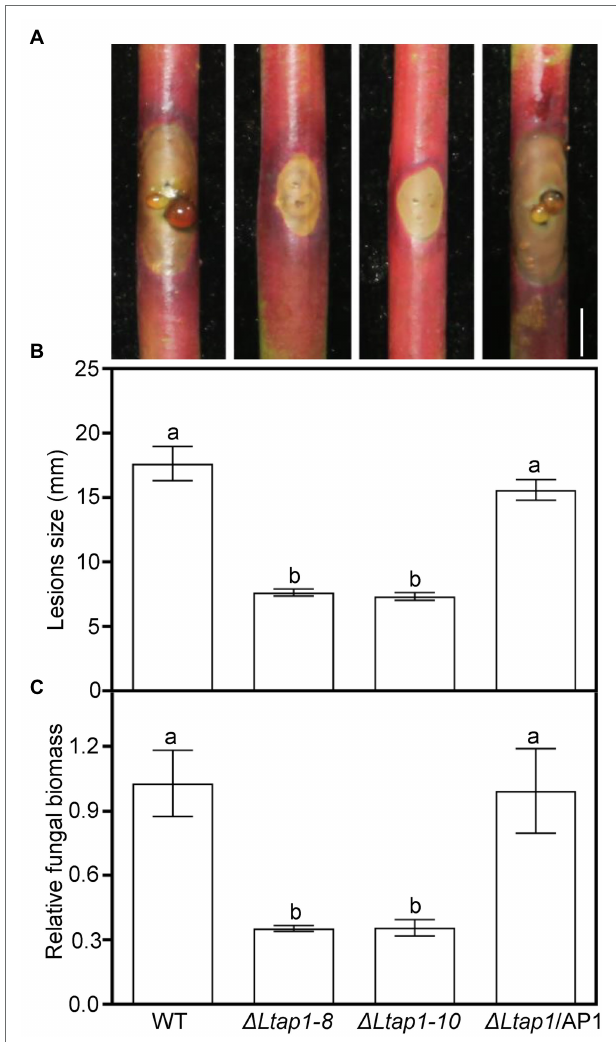
FIGURE 5 | Virulence test of the LtAP1 mutants into peach shoots. (A) Peach gummosis progression in the detached shoots inoculated with different genotypes of L. theobromae (WT, two deletion mutants, and the complementary strain Δ Ltap1 /AP1) at 5 dpi. Bar represents 5 mm. (B) Quantification of lesion size on inoculated peach shoots. (C) Quantitative real-time PCR (qRT-PCR) analysis of L. theobromae amounts in the infected peach shoots. In panels, different letters on top of bars indicate statistically significant differences at p <